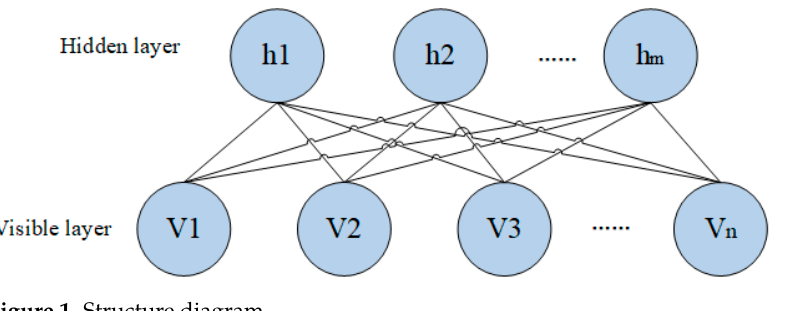
Figure 1. Structure diagram.